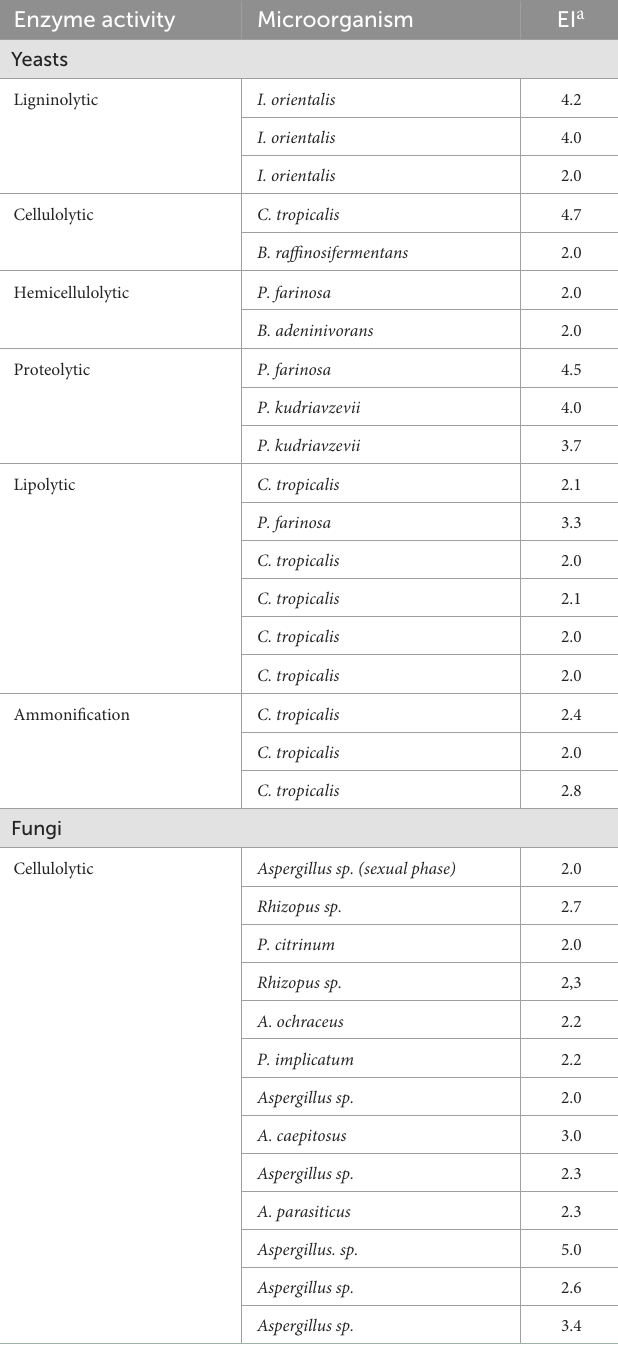
TABLE 7 Enzymatic activities of yeasts and fungi. Enzyme